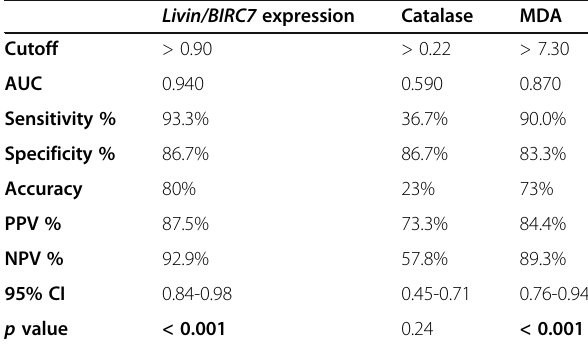
Table 6 Diagnostic performance of Livin/BIRC7 expression, catalase, and malondialdehyde (MDA) for differentiation between endometrial carcinoma and endometrial hyperplasia Livin/BIRC7